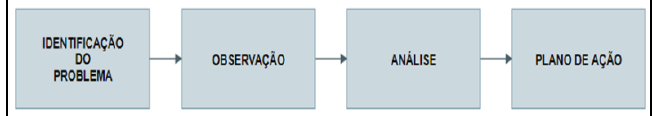
Figura 2: Sequência de aplicação das ferramentas segundo as etapas do MASP.